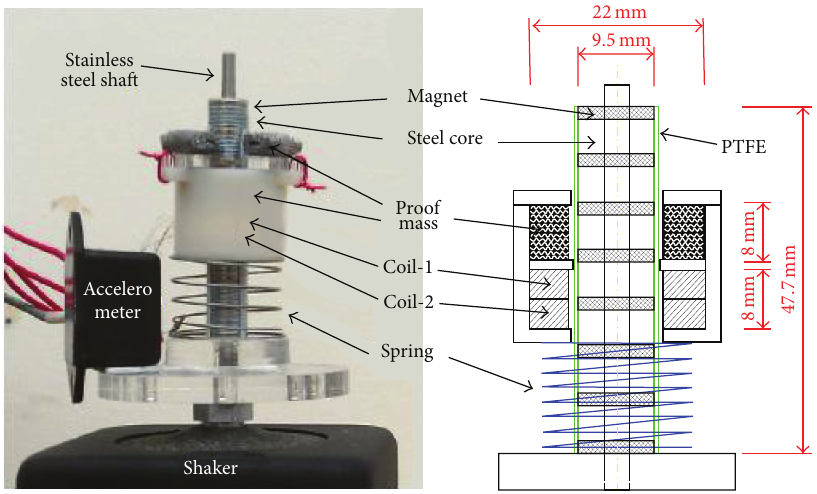
Figure 12: Device and experimental setup [16].